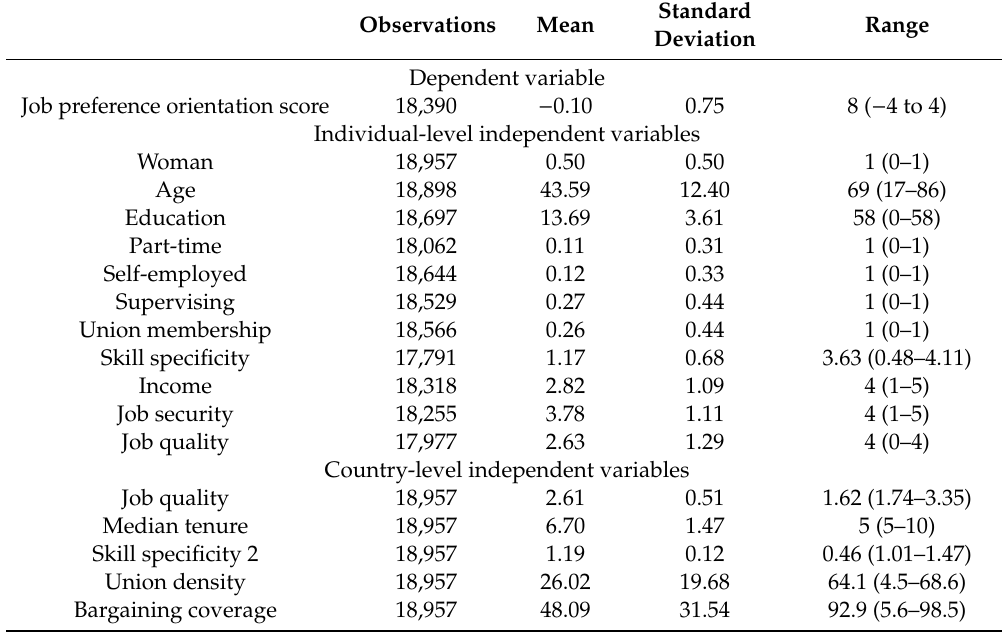
Table A2. Descriptive